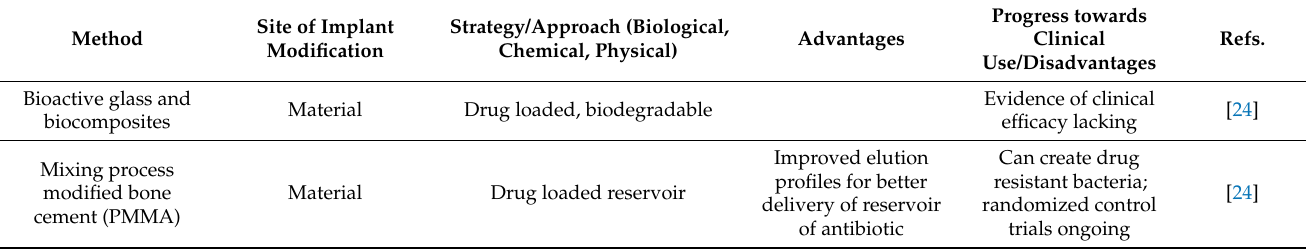
Table 1. Intrinsic methods. Methods that make use of physical, chemical or biological aspects of the implant itself to prevent or reduce biofilm formation and